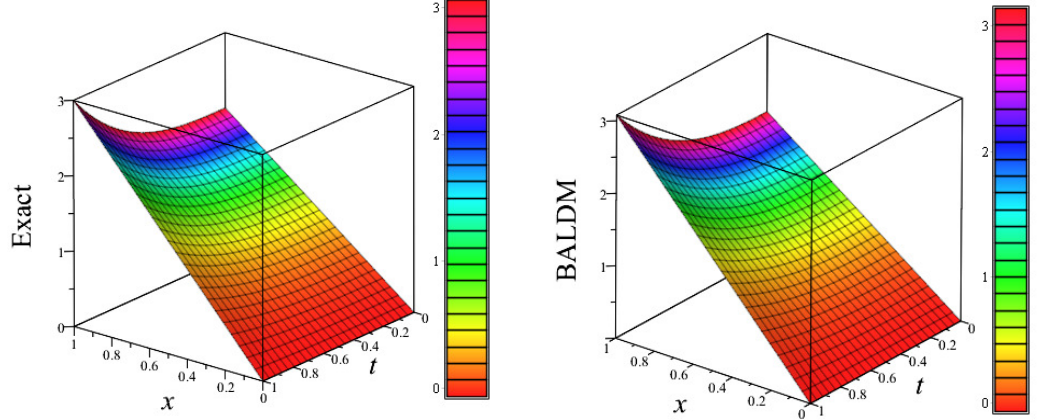
Figure 14. 3D plots of exact solution and sum of the first five approximate solution, Ψ 5 ( x , t ) , using BALDM, vs. x vs. t for numerical experiment